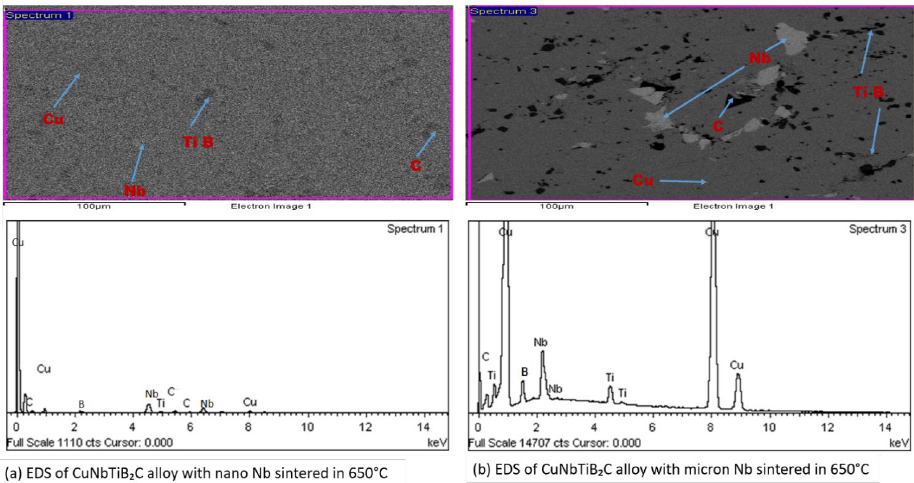
Figure 2. ( a ) and ( b ) compare the EDS graph,of CuNbTiB 2 C alloys with nano and micron both sin- Figure 2. ( a , b ) compare the EDS graph,of CuNbTiB 2 C alloys with nano and micron both sintered at tered at 650 °C. 650 ◦